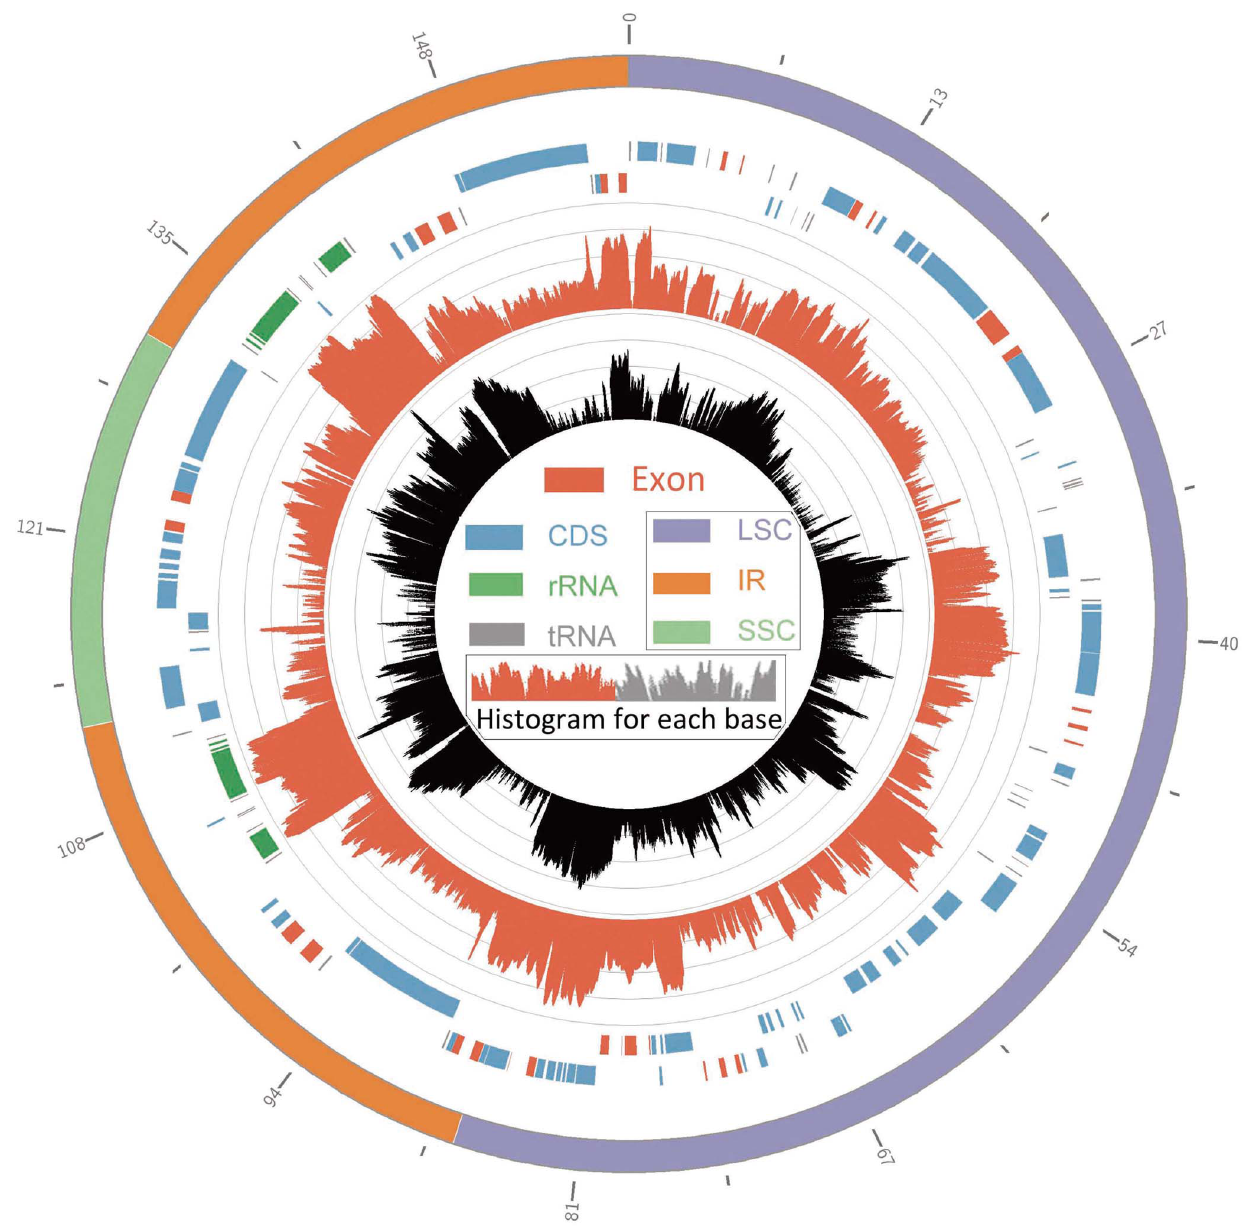
Figure 5. Circular plot of transcriptome reads mapping of the C.sinensis var. assamica chloroplast genome. The first ring shows genome structure of C. sinensis var. assamica , while the second and third rings show genes in the Camellia chloroplast genome that transcribed clockwise and counter clockwise, respectively. The next two rings show transcriptome reads from C. sinensis var. assamica and C. sinensis var. sinensis were separately mapped to the genome. Log 10 of reads depth for each base was calculated and plotted across the genome. The figure was constructed using Circos [57]. Table S2) were used to close the gaps and verify sequence assembly.